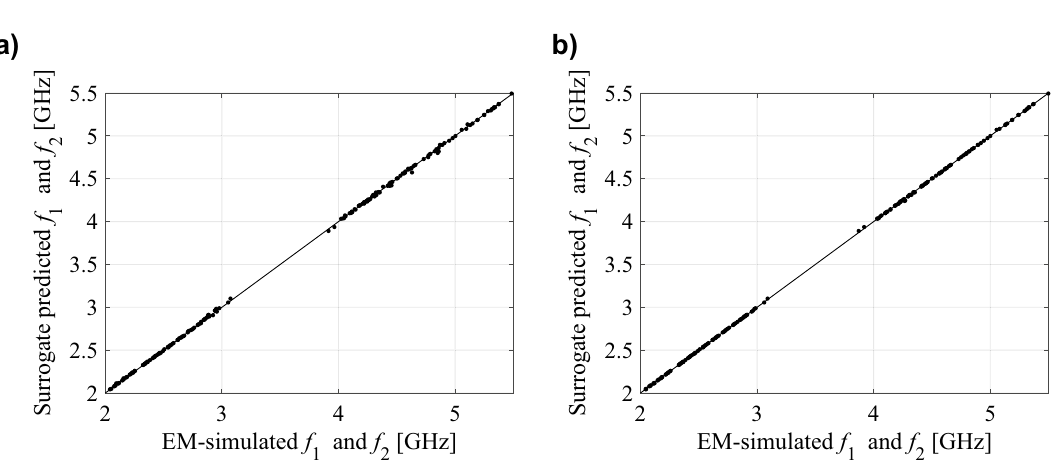
Figure 6. Dual-band antenna of Fig. 4b: scatter plots of the center frequencies f 1 and f 2 [GHz] yielded by the proposed surrogate against their EM-simulated counterparts; surrogates constructed using ( a ) N B = 20 and ( b ) N B = 100